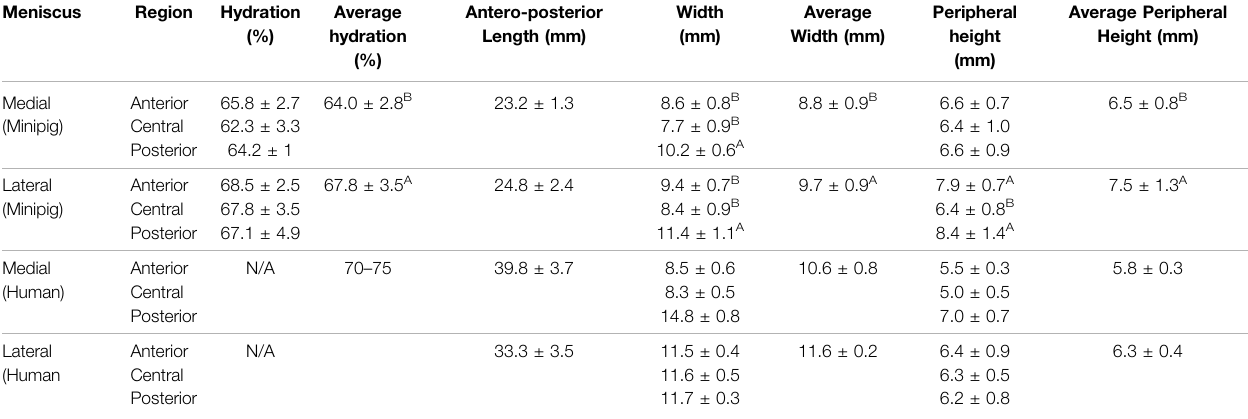
TABLE 1 | Morphological properties of minipig menisci. Student ’ s t -test showed a signi fi cant difference between medial and lateral menisci in hydration, width, and peripheral height values. For comparison of regions within each meniscus, Tukey ’ s HSD test showed signi fi cant differences among regions for both menisci in width, while the lateral meniscus exhibited differences in peripheral height values among its regions. Values marked with different letters within each category are signi fi cantly different among groups ( p < 0.05), n = 7 – 8 per group. Human values of morphological properties from the literature are shown for comparison (Proffen et al., 2012; Takroni et al.,